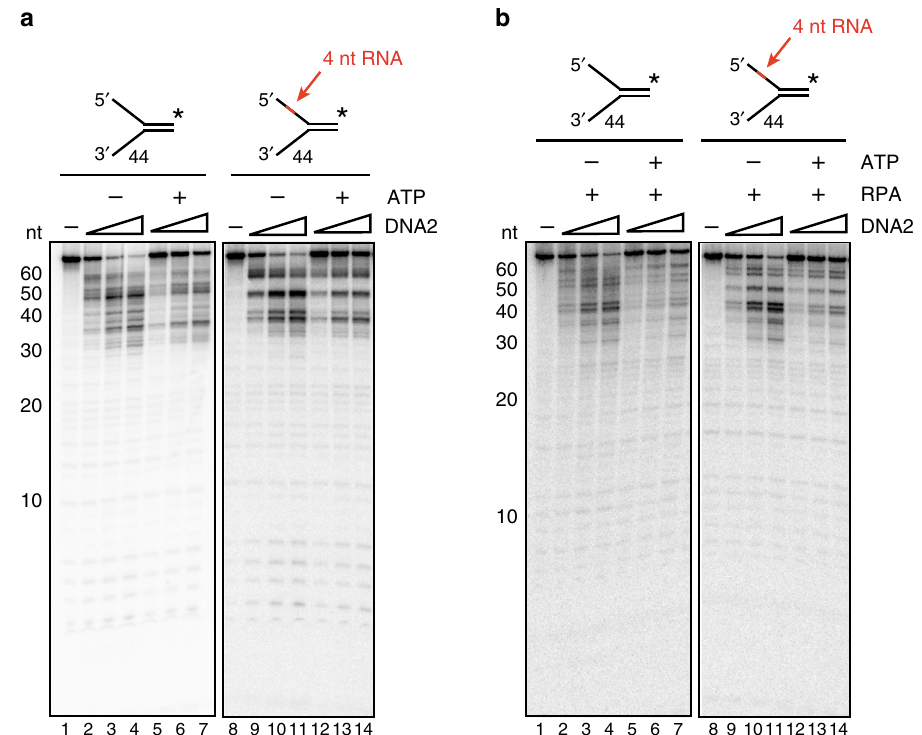
Fig. 4 DNA2 cannot cleave within stretches of RNA. a DNA2 (0.25, 0.5, 0.75 nM) was incubated with the indicated Y-shaped substrate (2.5 nM) at 37 °C for 5 min in the presence or absence of 2 mM ATP. Reaction mixtures were resolved in a 20% denaturing polyacrylamide gel. b The same assay was done in the presence of RPA (10 nM). Reaction mixtures were resolved in a 20% denaturing polyacrylamide gel. Error bars in all the panels represent the standard deviation of results from n = 3 independent experiments, and all points represent the mean. RNA is denoted in red, and the asterisk indicates the location of the